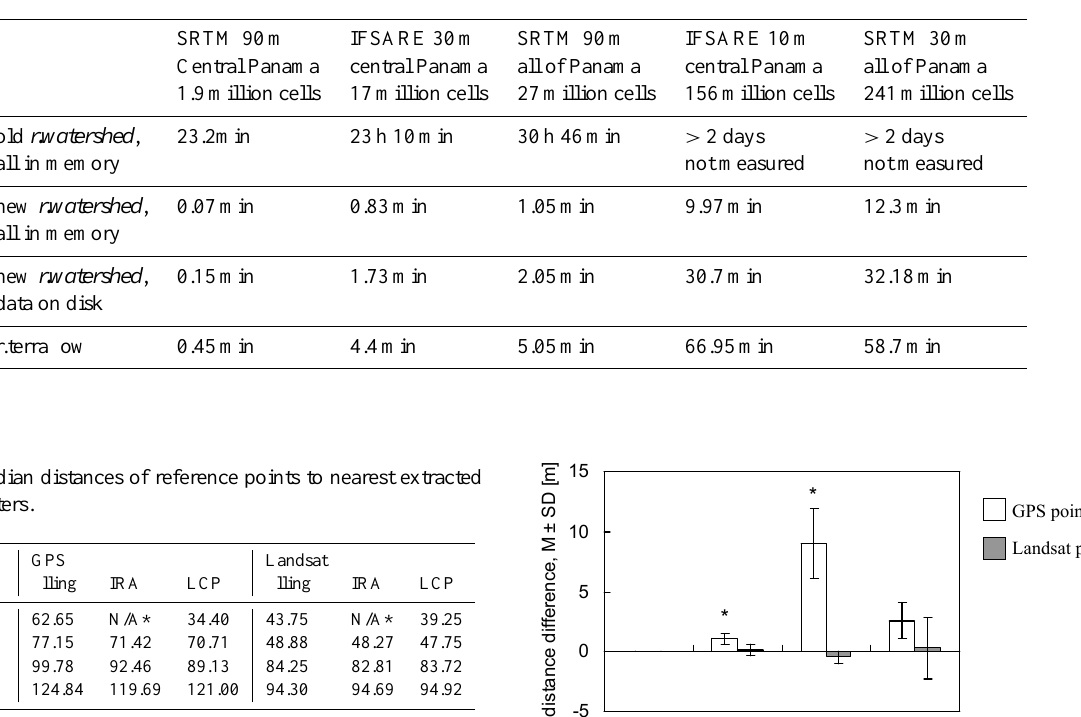
Table 1. Processing time for the different DEMs on a Linux 64bit system with an AMD Athlon X2 3GHz CPU and 8GB RAM.